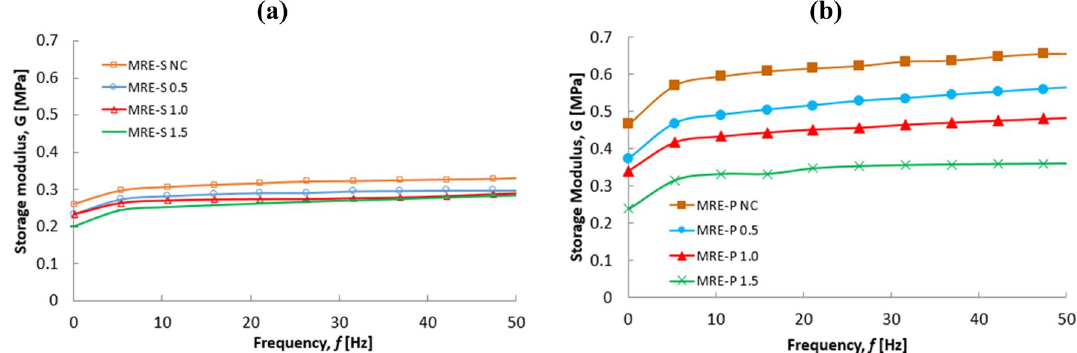
Figure 10. Storage modulus versus frequency of MREs containing ( a ) spherical and ( b ) plate-like shapes at off- state (0A)